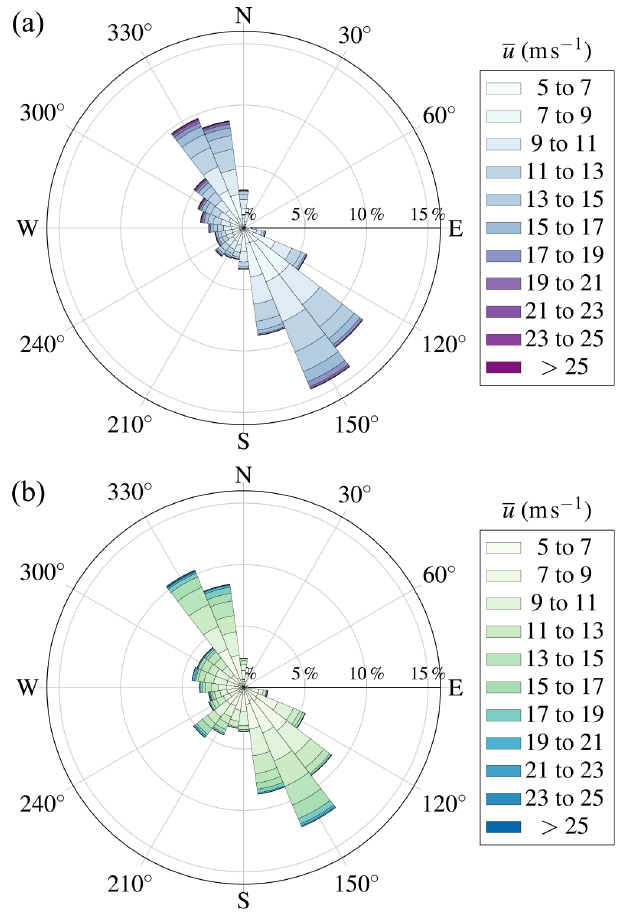
Figure 3. Wind roses computed using 10min mean wind records from 1990 to 2020 (a) and from March 2019 to March 2020 (b) , 10m above the ground by the Obrestad Lighthouse weather station. Only samples associated with u ≥ 5ms − 1 are considered for the sake of clarity.